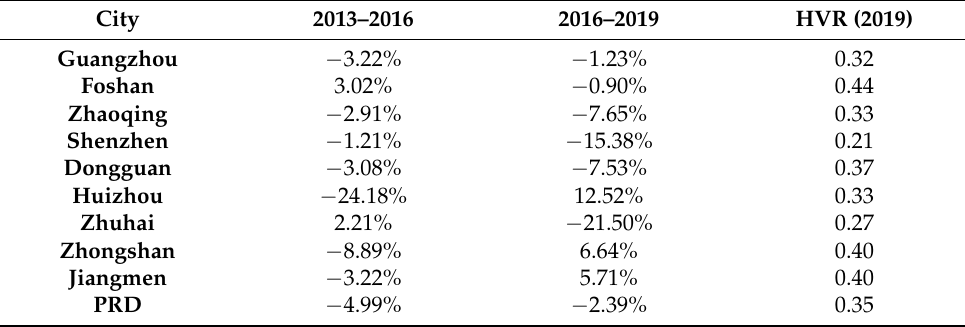
Figure 9. Spatial distribution of HVRs changes in the PRD. ( a ) 2013–2016, ( b ) 2016–2019, ( c ) 2013–2019. Table 4. HVR changes of individual cities in the PRD